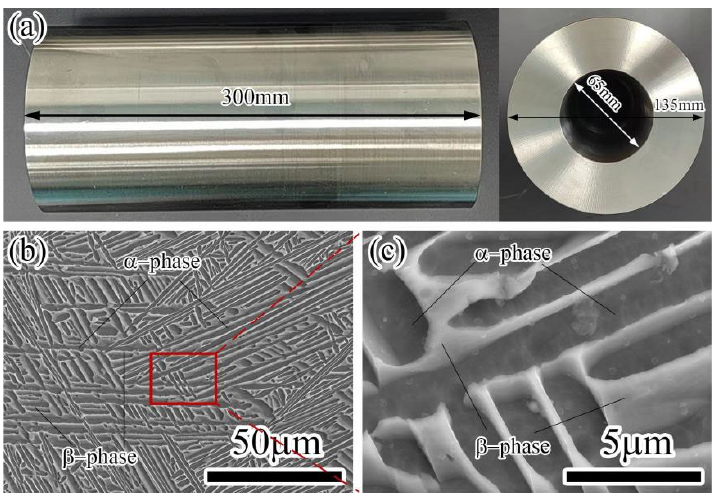
Figure 1. Dimensions and microstructures of TC21 titanium alloy sample: ( a ) sample dimensions; ( b ) SEM image with relatively low microscope magnification; ( c ) SEM image with high microscope magnification.